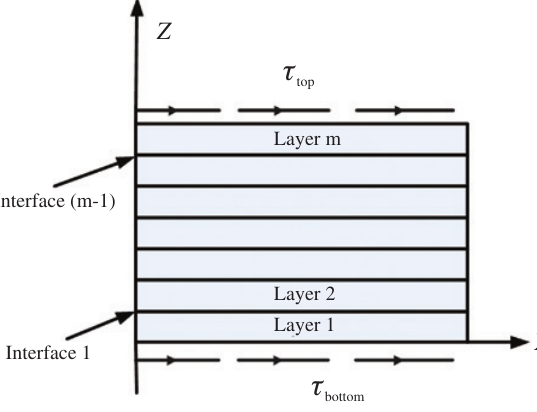
Figure 3: Model of the